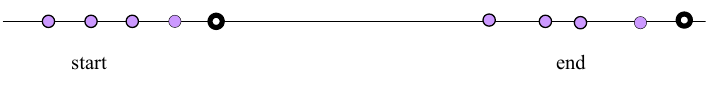
Figure 8. The distances between the robots changed over time.